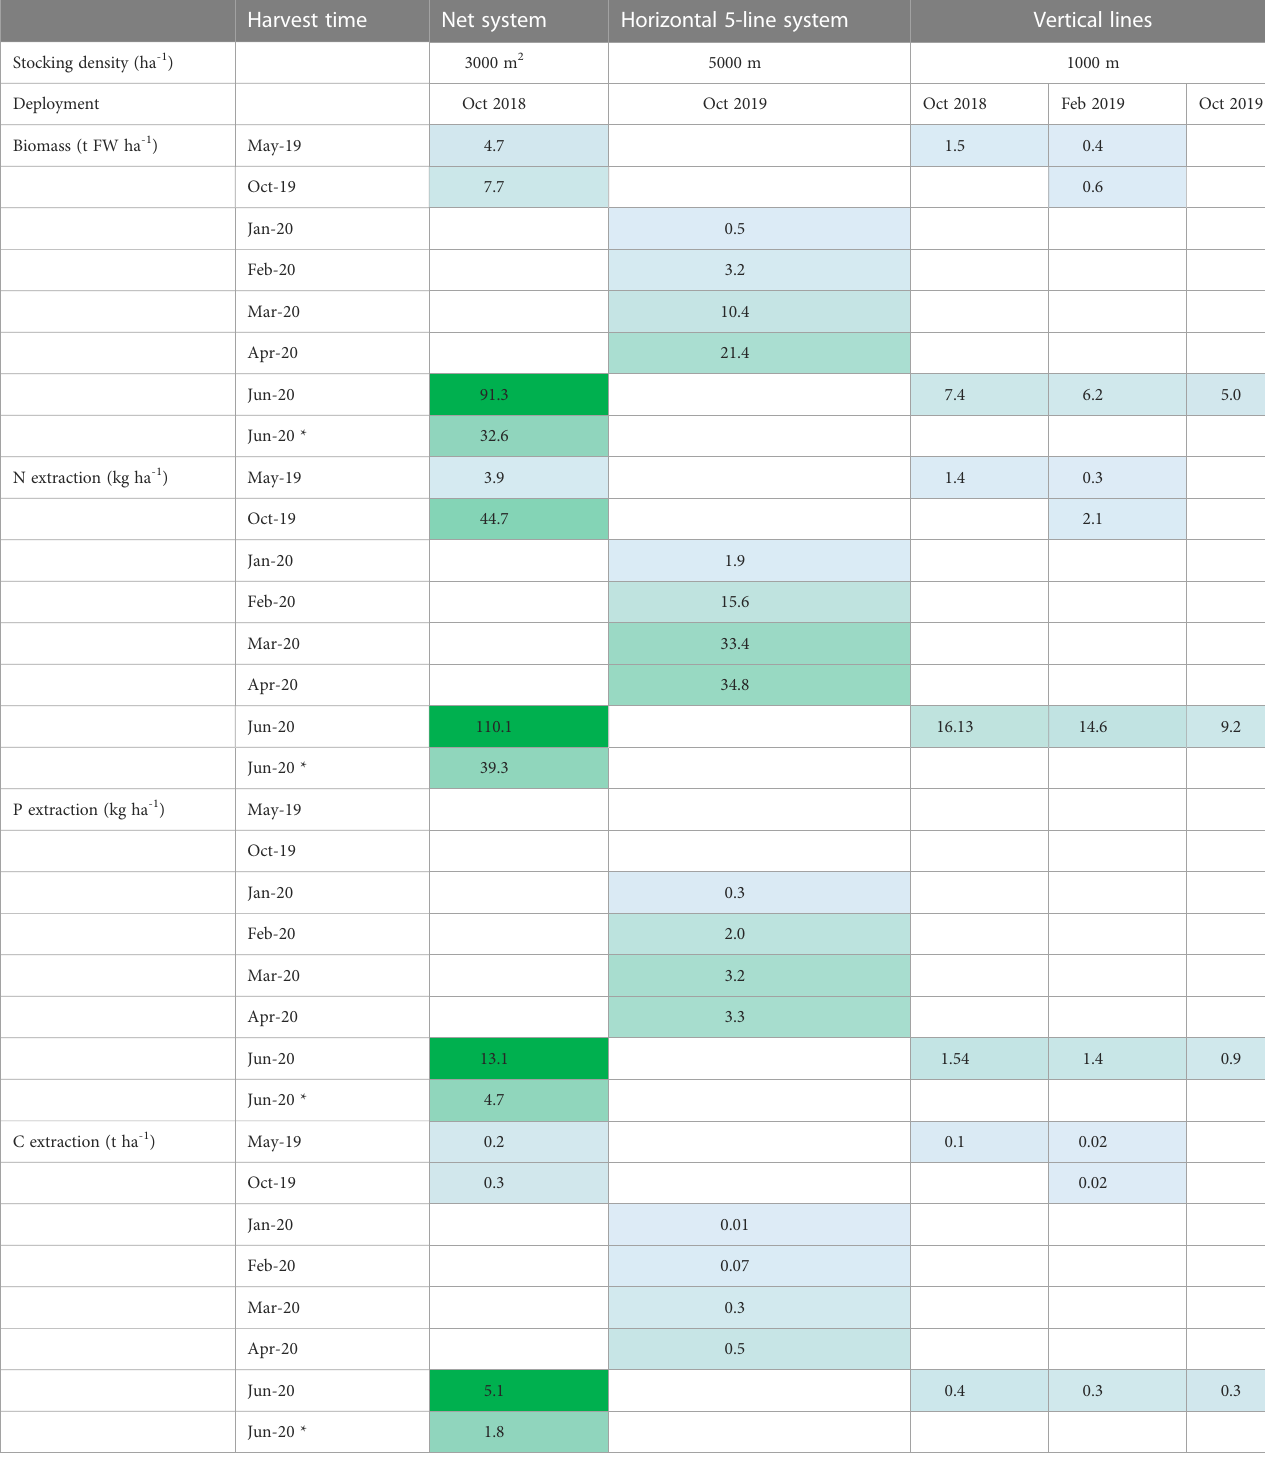
TABLE 4 Extrapolated biomass yields (t FW ha -1 ) and nutrient and carbon extraction potentials (kg N, P and t C ha -1 ) from the three infrastructure design systems, with the biomass stocking density in the farm taken into account. Harvest time Stocking density (ha -1